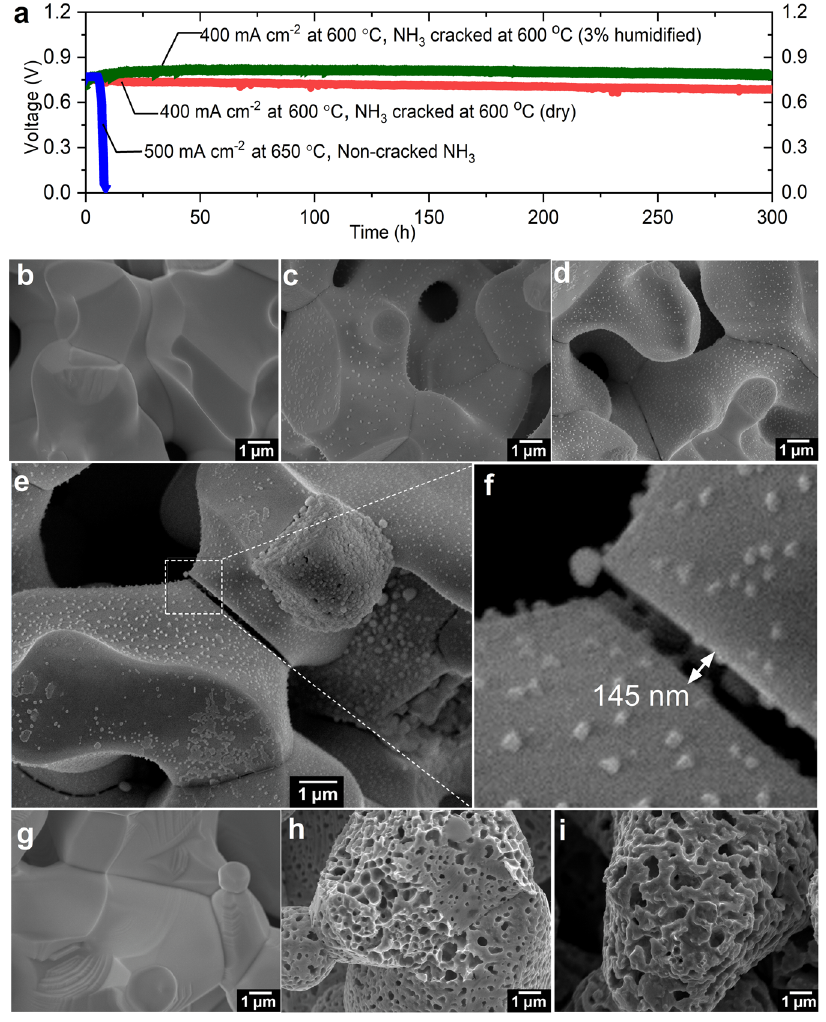
Fig. 4 Investigation on stability and degradation mechanism in NH 3 -fed PCFC. a Stability test for NH3-fed PCFC with and without Ru-B2CA catalyst. b , c SEM images of as sintered BCZYYb (with 1 wt% NiO added via solid state reaction synthesis process) and after H 2 reduction, respectively. d – f , BCZYYb (with 1 wt% NiO) after non-cracked NH 3 reduction at different magni fi cation and grains boundaries. g – i SEM images of as sintered NiO, after H 2 reduction and after non-cracked NH 3 reduction,